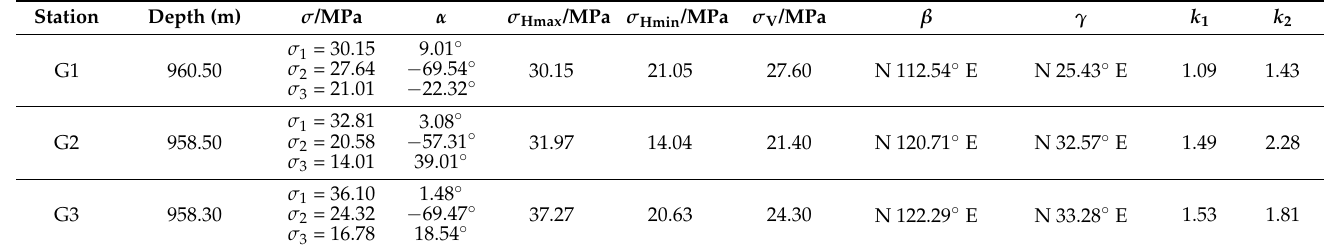
Table 1. In-situ stress measurement results obtained at different